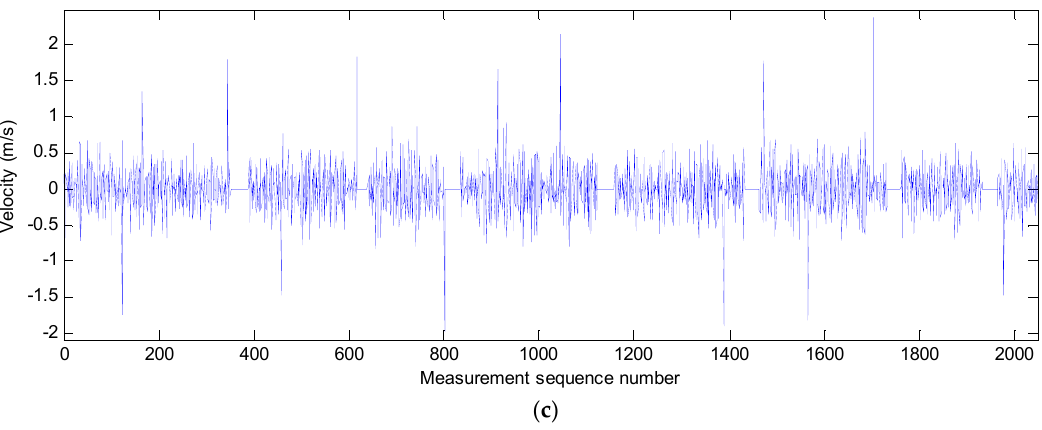
Figure 3. Movement velocity data sequences of the SBF7-1A GPS wave buoy in three directions before correction at 03:00 (UTC) on 2 July 2013: ( a ) movement velocity data sequence in the east–west direction; ( b ) movement velocity data sequence in the north–south direction; and ( c ) movement velocity data sequence in the vertical direction.